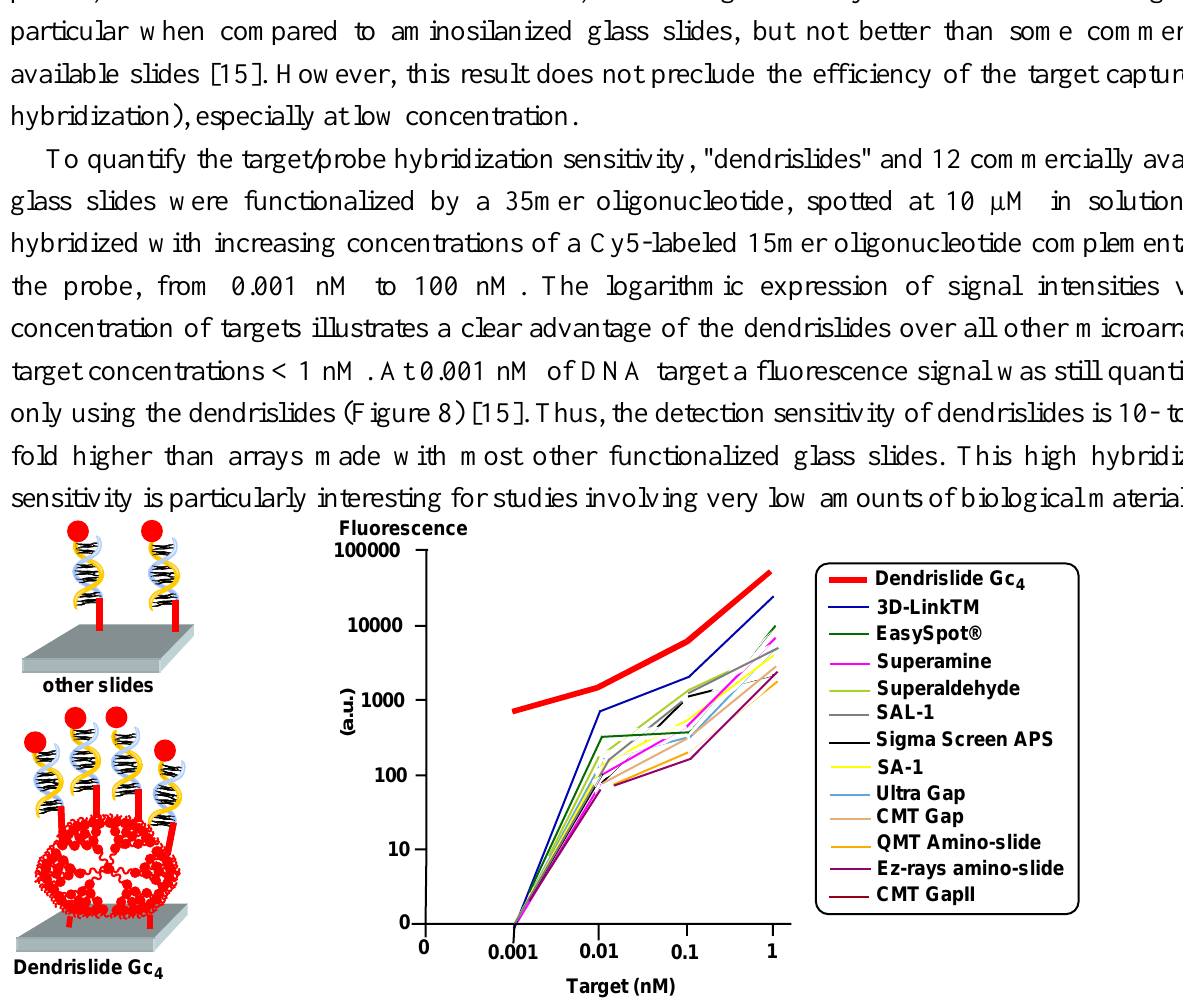
Figure 8. Measurement of the hybridization efficiency of the "dendrislide" elaborated from Gc compared to the efficiency of 12 commercially available slides. A fluorescence signal is detectable only with the dendrislide at 1 pM concentration of